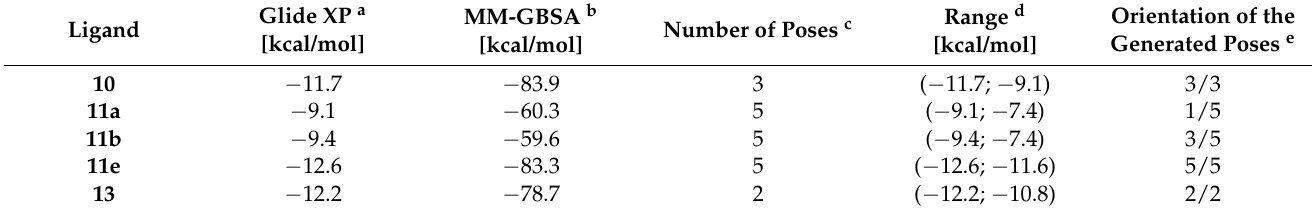
Table 3. Top-scoring docking solutions for the selected five novel compounds showing the highest biological activity against Pyricularia oryzae . a Glide XP Score indicates the approx. binding affinity (kcal/mol) of the top-scoring binding poses. b MM-GBSA indicates a more accurate binding affinity (kcal/mol) of the top-scoring binding pose. c Number of poses for each compound obtained by the molecular docking procedure. d Range of the binding affinities (kcal/mol) of individual poses for each tested novel compound. e Number of generated poses with an orientation similar to azoxystrobin (as transferred from the template) for each tested novel compound.